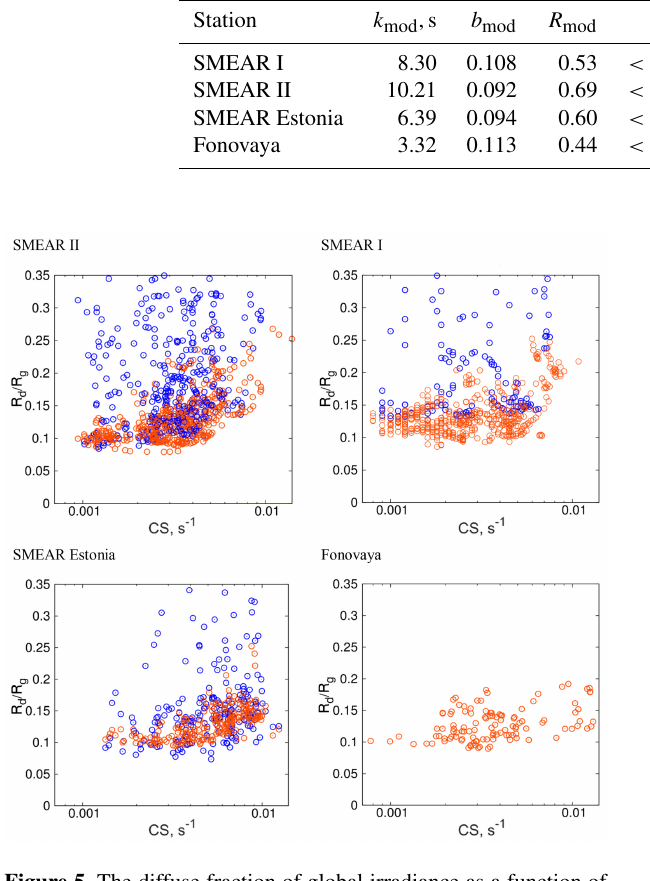
Figure 5. The diffuse fraction of global irradiance as a function of CS (clear-sky data). The red symbols represent calculations with the clear-sky model, and blue symbols represent